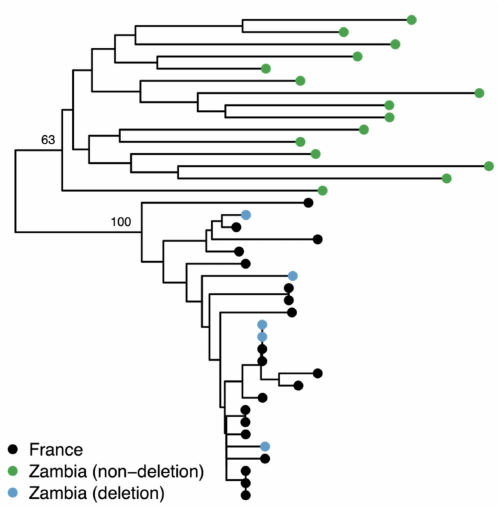
Figure 4. Neighbor-joining tree of the 15 kb region surrounding the MtnA gene for 20 Zambian and 20 French sequences. The Zambian sequences containing the MtnA 3’ UTR deletion (blue) cluster together with the French sequences (black) with 100% bootstrap support, which is consistent with recent admixture in this region of the genome. The tree was rooted using D. sechellia and D. simulans as